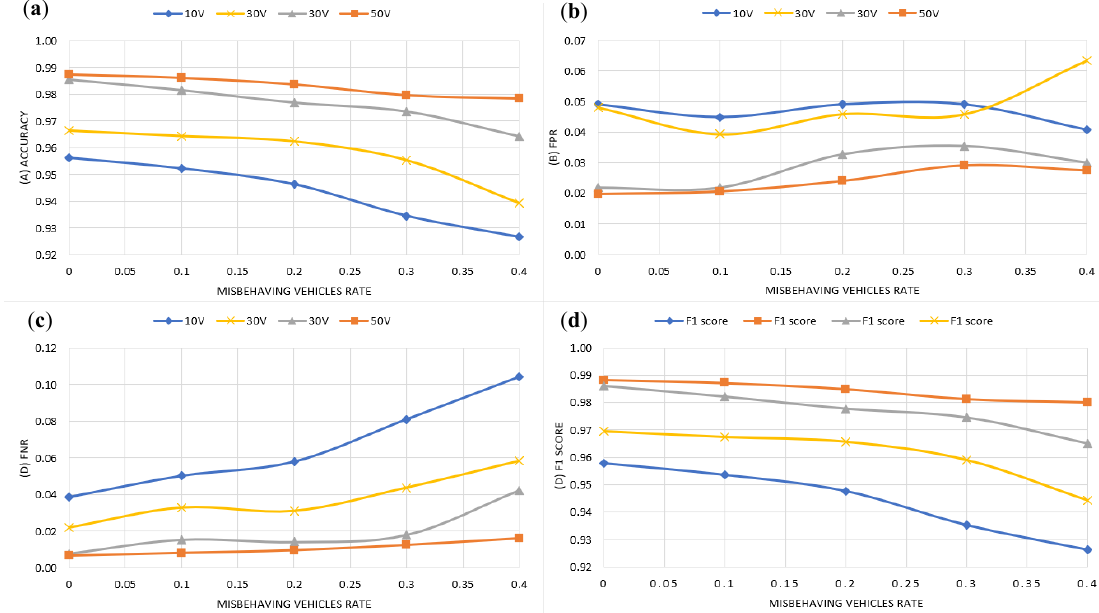
Figure 5. Impact of increasing the percentage of misbehaving vehicles on the detection performance in terms of ( a ) Accuracy, ( b ) False Positive Rate, ( c ) False Negative Rate, and ( d ) F1 Score.